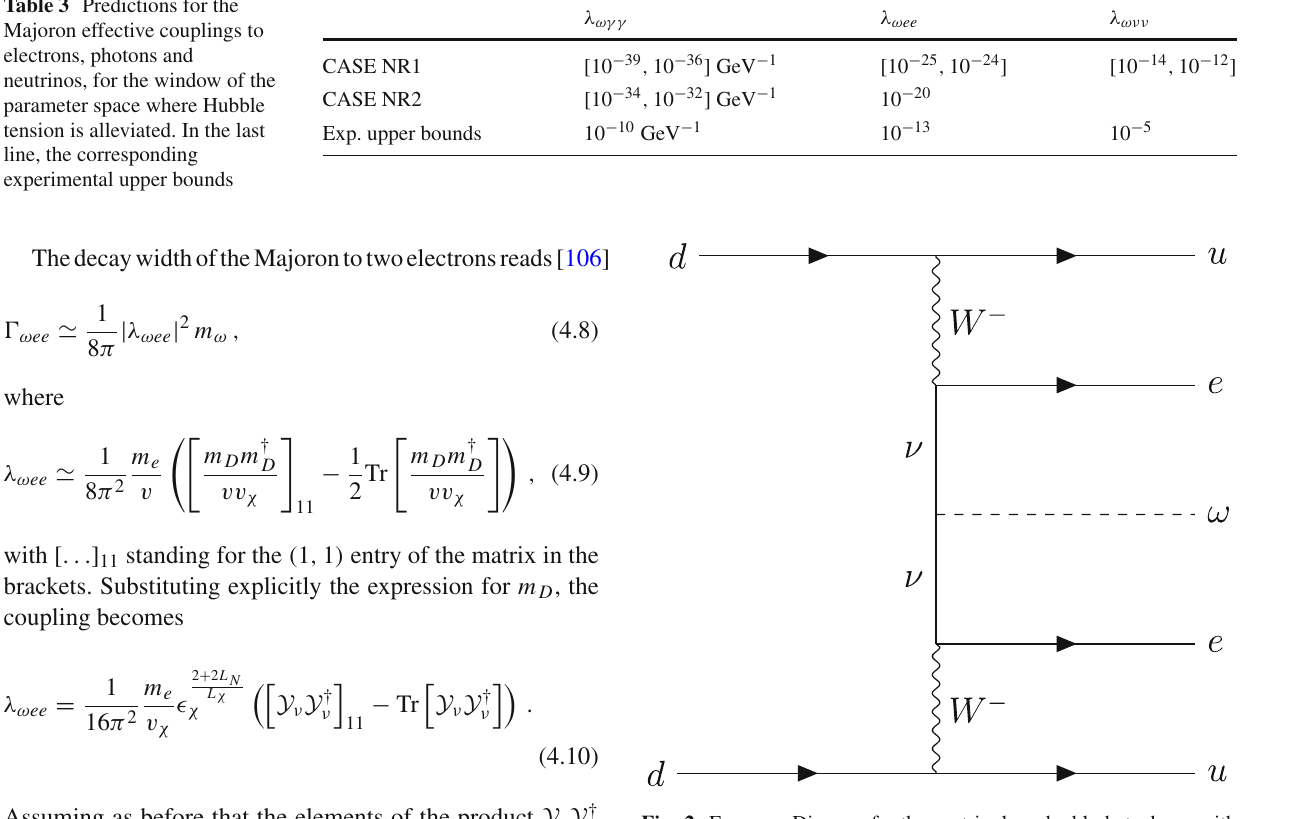
Fig. 2 Feynman Diagram for the neutrinoless-double-beta decay with the emission of a